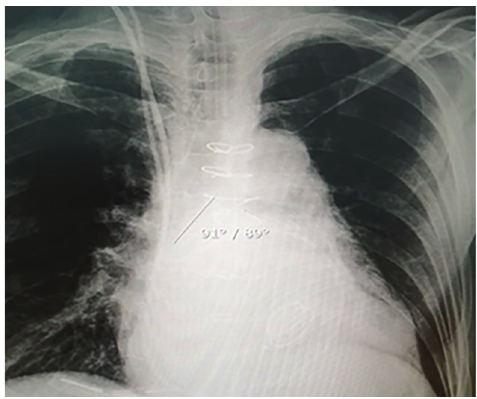
Figure 3 - Chest X-Ray in dynamics (24 hours after surgery)